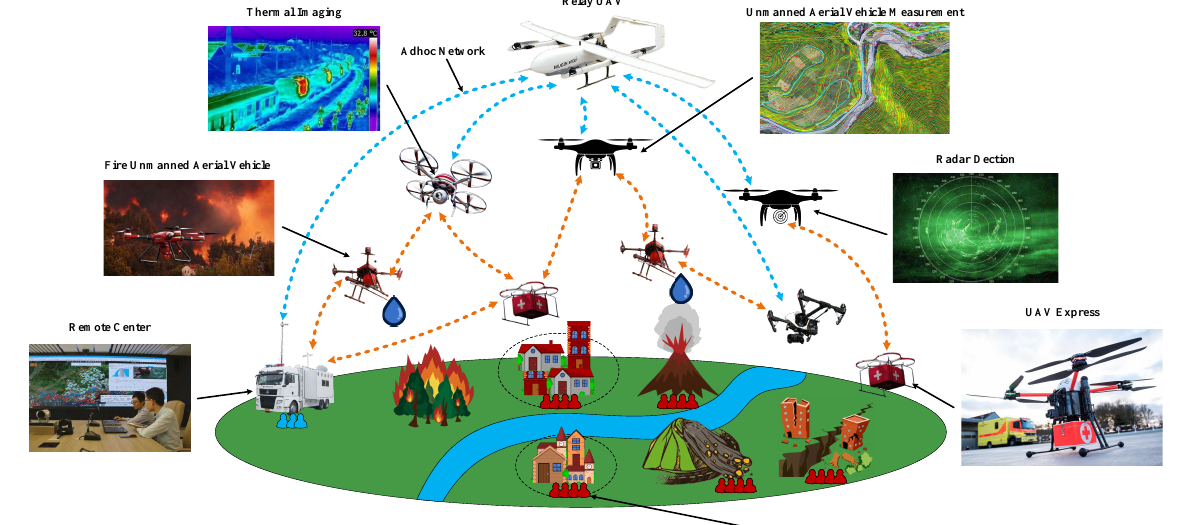
Figure 1. The important role of drones in disaster